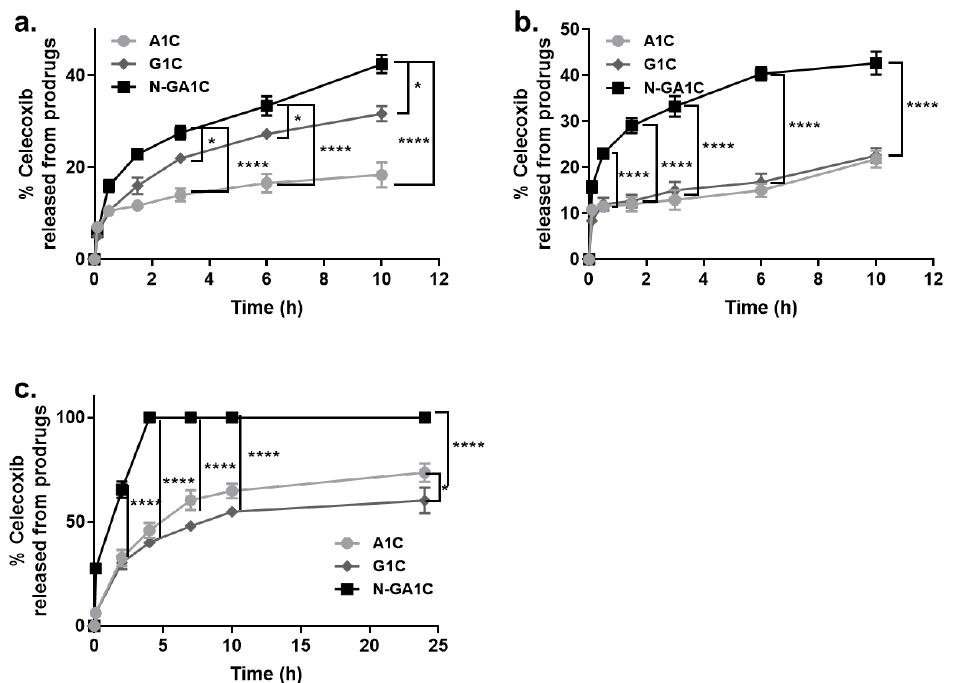
Figure 1. Amino acid conjugates of celecoxib release celecoxib in both small- and